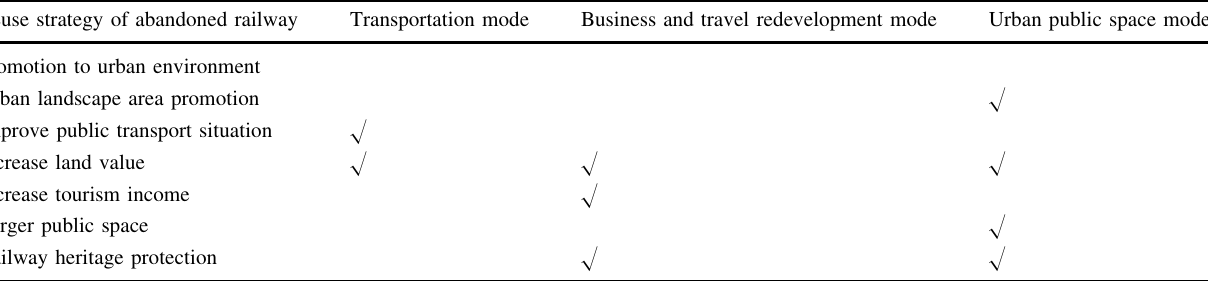
Table 1 Main impact of different transformation modes on the urban environment. Source : Drawn by the authors Reuse strategy of abandoned